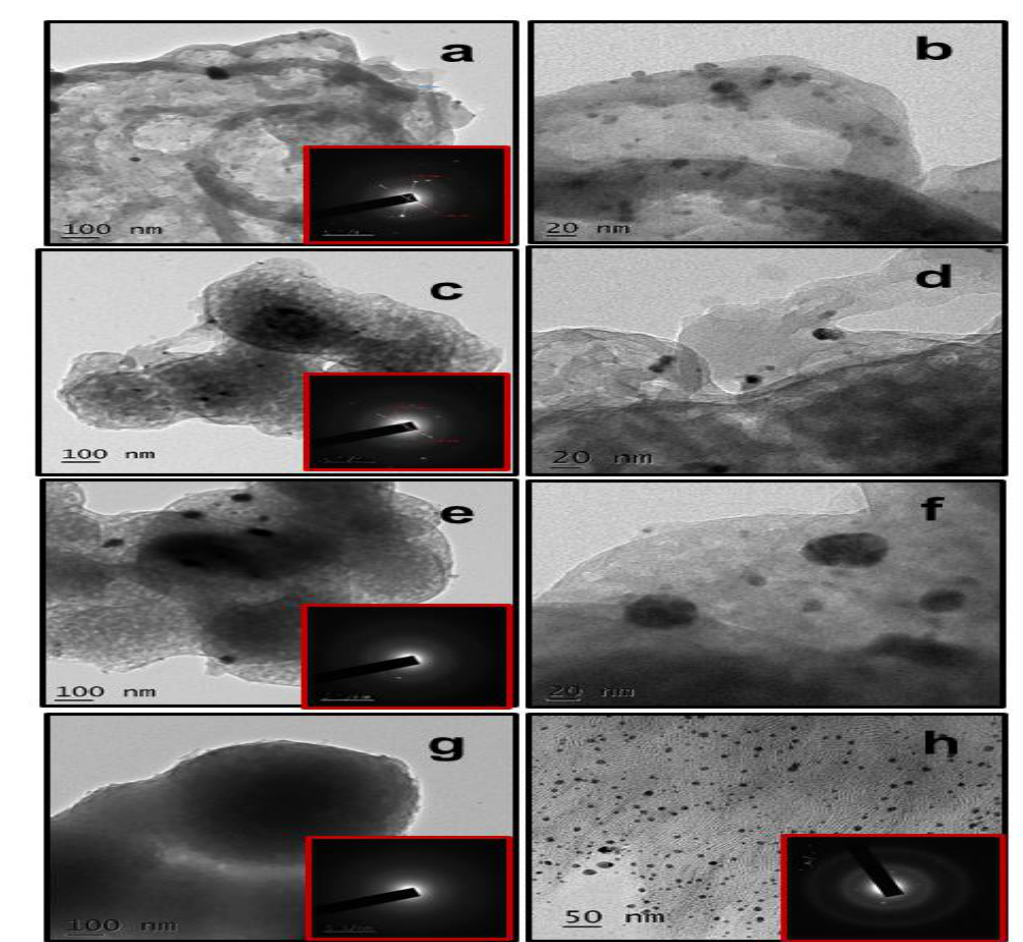
Fig. 5. TEM images of Gr-Ag-5/PNA (a and b) Gr-Ag-10/PNA (c and d) Gr-Ag-20/PNA (e and f), PNA (g) and AgNPs (h), and SAED patterns of Gr-Ag-5/PNA Gr-Ag-10/PNA, Gr-Ag-20/PNA, PNA, and AgNPs (inset a, c, e, f, g, and h,